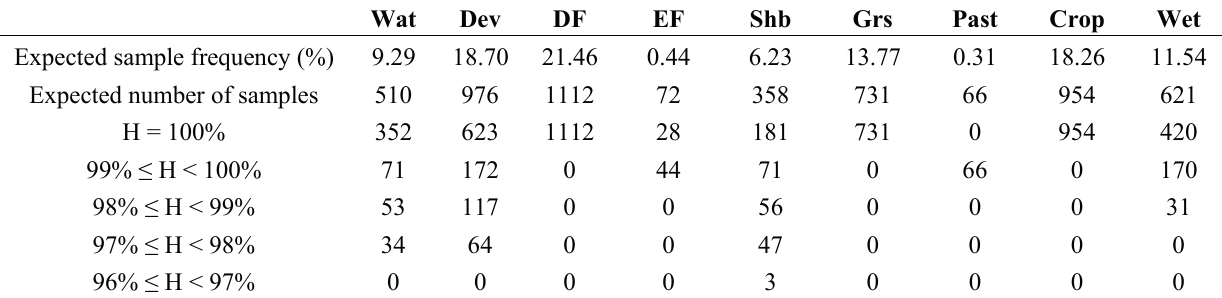
Table 4. Random allocation with a minimum of 50 samples per class using homogeneous pixels H = 100%. Homogeneity (H) in percent. See Table 1 for abbreviations of class